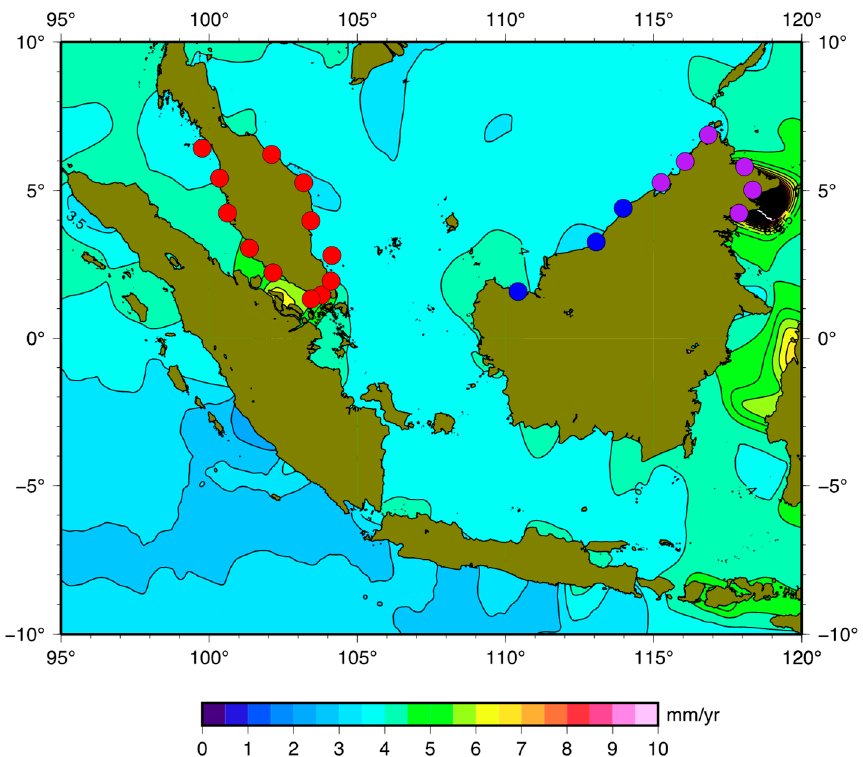
Figure 2. Geographical location of the 21 tide gauges, 12 in Peninsular Malaysia and 9 in East Malaysia. The colors indicate the trend in sea level anomaly from satellite altimetry for this region (yr = year). The y -axis is the latitude (N) and the x -axis is the longitude (E), both given in degrees.